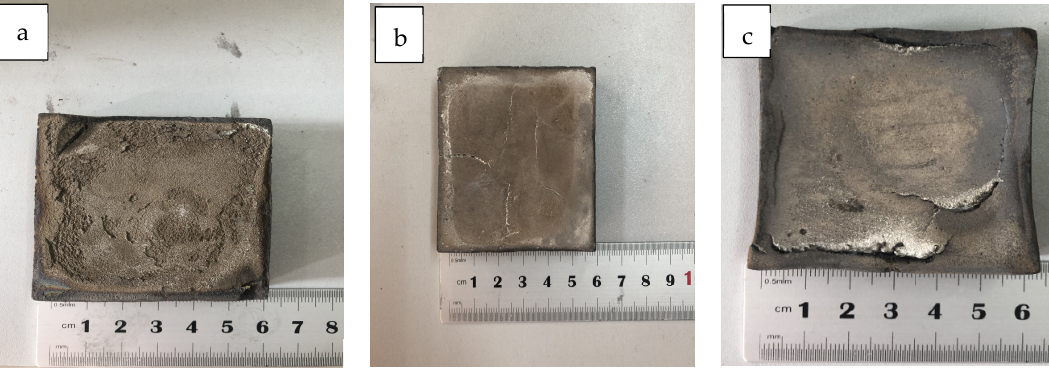
Figure 5. Hot-pressed magnesium alloys: ( a ) Mg-0.5%Mn-2%Zn, ( b ) Mg-1%Mn-2%Zn, and ( c )